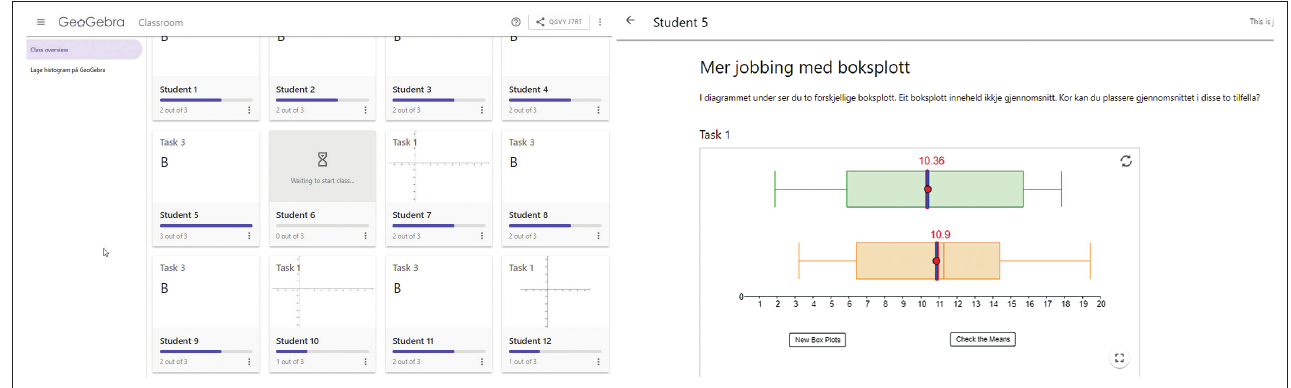
FIGURE 6: GeoGebra data collected showing the progress of all students’ engagement in solving a task related to making histograms (left) and one student’s engagement in estimating where the mean of a data set lies given the boxplot of that data